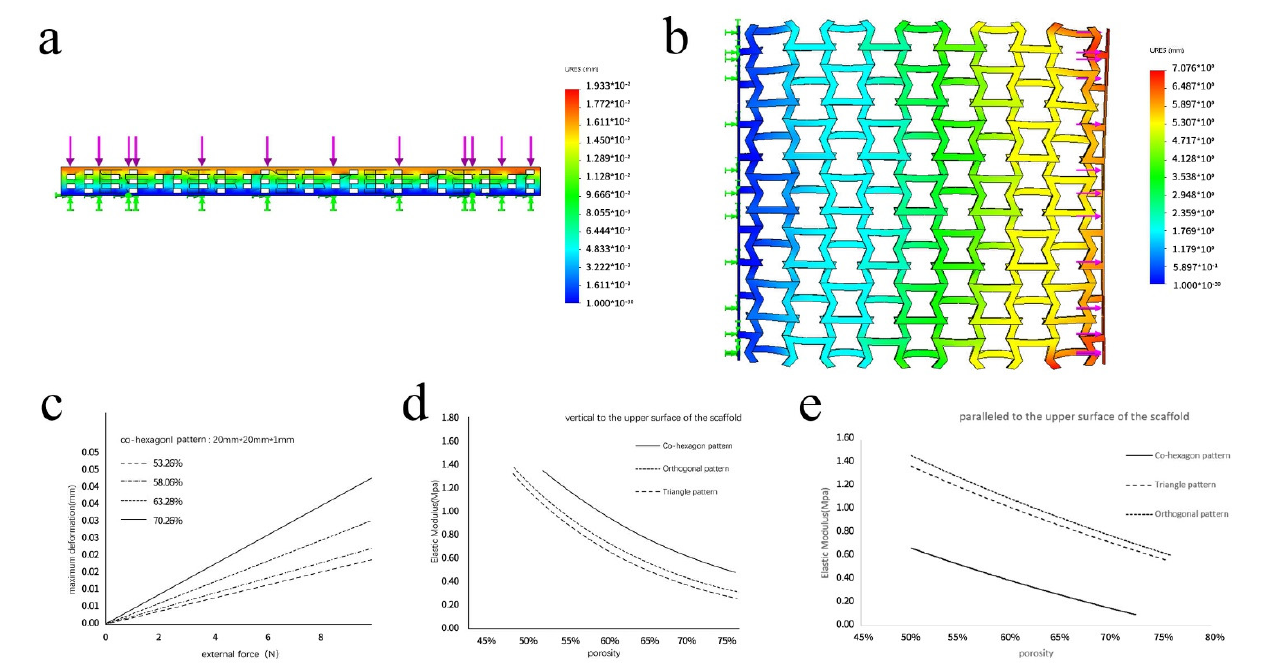
Figure 8. Simulation results for the scaffold of different filled structures: deformation in the direction perpendicular to the upper surface ( a ) or parallel to the upper surface ( b ), stress-strain curves for different pores ( c ), and elastic modulus versus porosity in both directions ( d , e ).